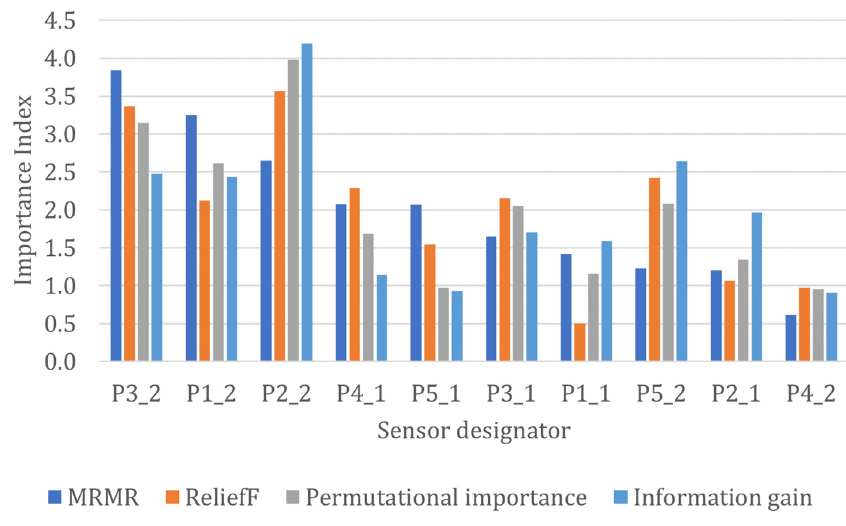
Figure 7. Importance of specific sensors.